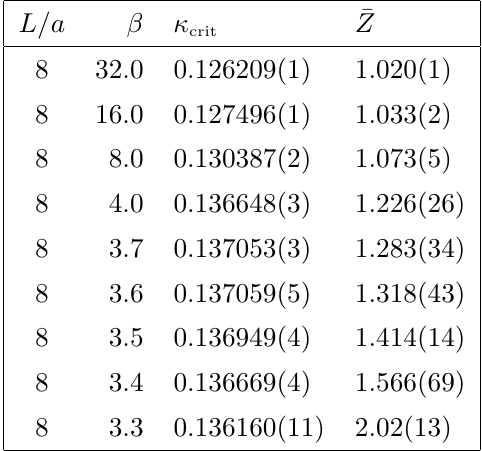
Table 1. Values of the critical hopping parameters (cid:20) by linearly interpolating data in the range combined linearly with the absolute di(cid:11)erence to the corresponding values obtained by removing the outermost data points from the least square